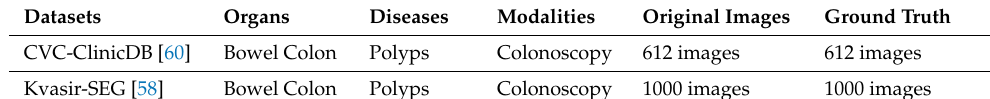
Table 3. Summary of the Datasets.